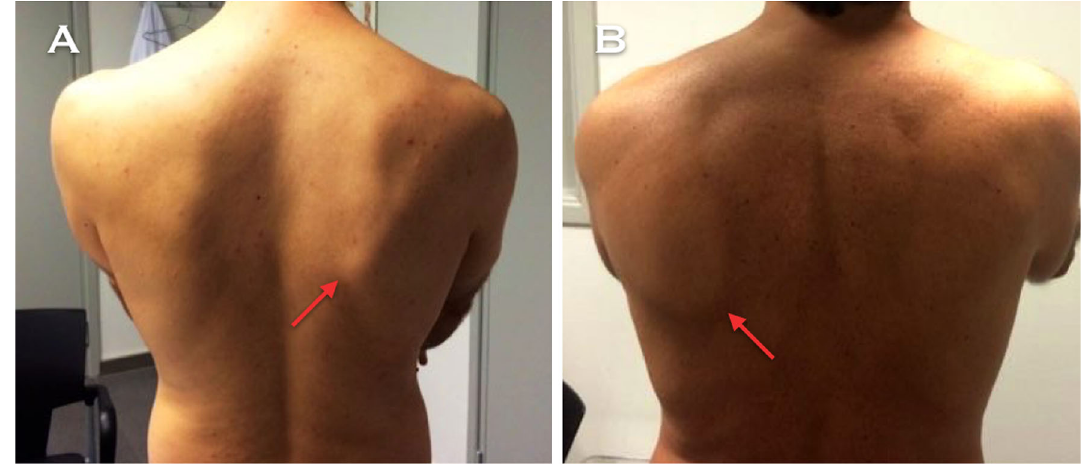
Fig. 7 a and b Posterior perspective of two patients performing shoulder forward flexion. Notice that the inferomedial border of the right scapula ( red arrows ) shows a prominence. These two patients had a history of chronic unstable ACJ injuries that were